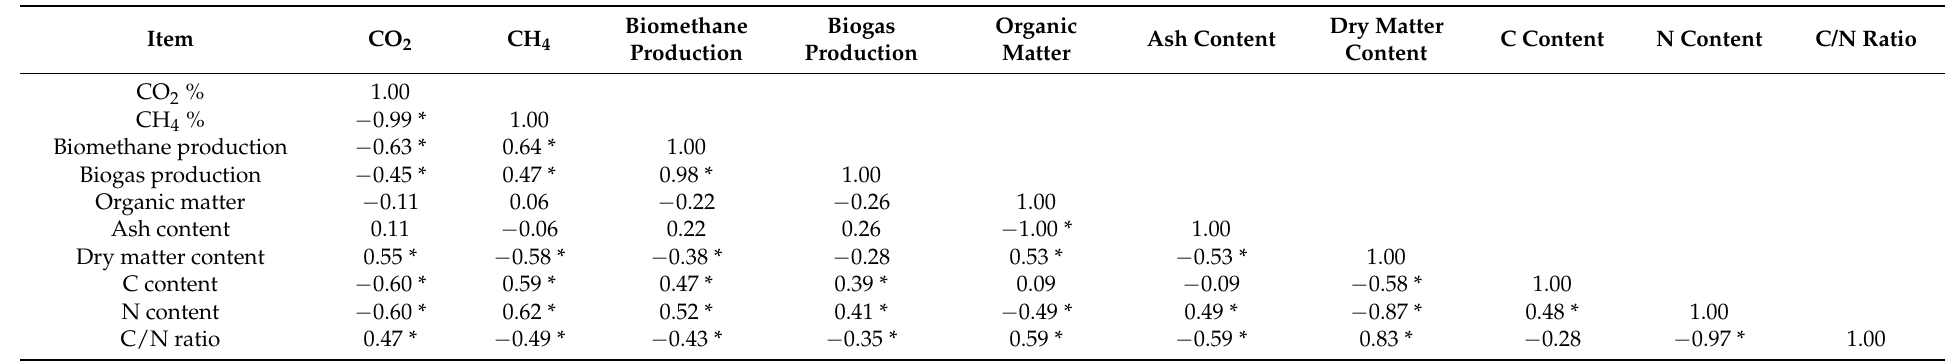
Table 4. The Pearson correlation coefficients for the analyzed